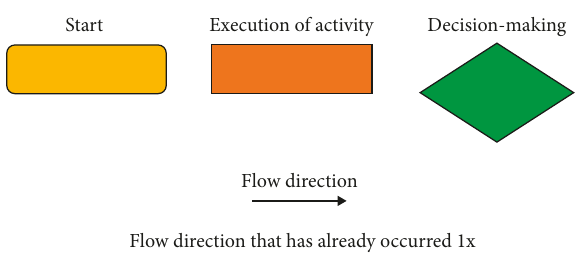
Figure 6: Icons used in the analysis of workflows and their re- spective